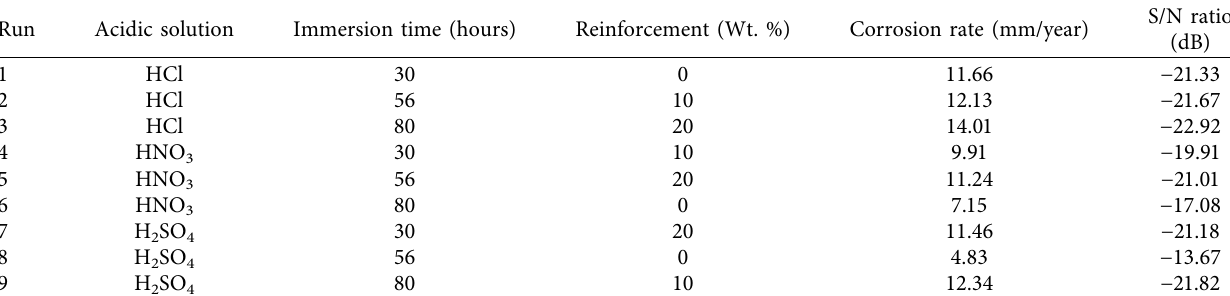
Table 3: Corrosion experiment values and their corresponding S/N